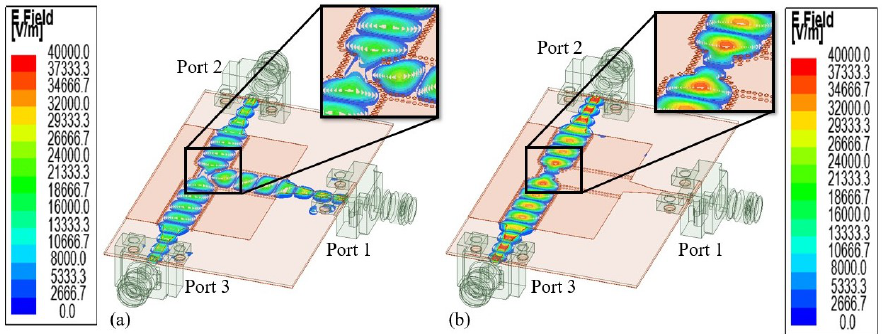
Figure 5. Modes (electric field) intensity for power combiner with λ /2 line, ( a ) 180° out-of-phase excitation of port 2 and port 3 ( b ) In-phase excitation of port 2 and port 3 [red and blue show highest and lowest intensity, respectively].